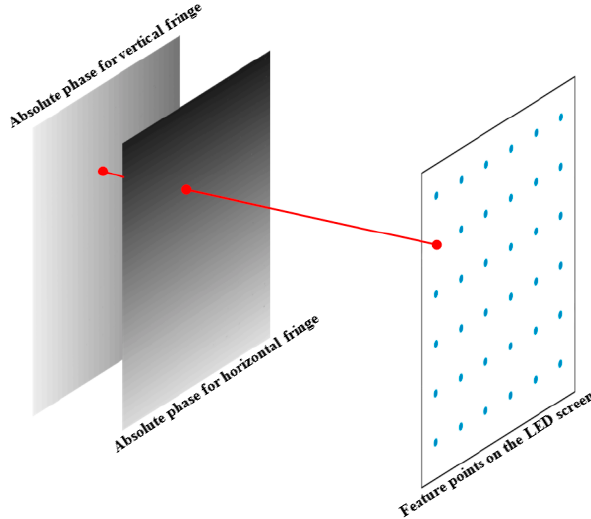
Figure 4. Feature point matching using absolute phase data.